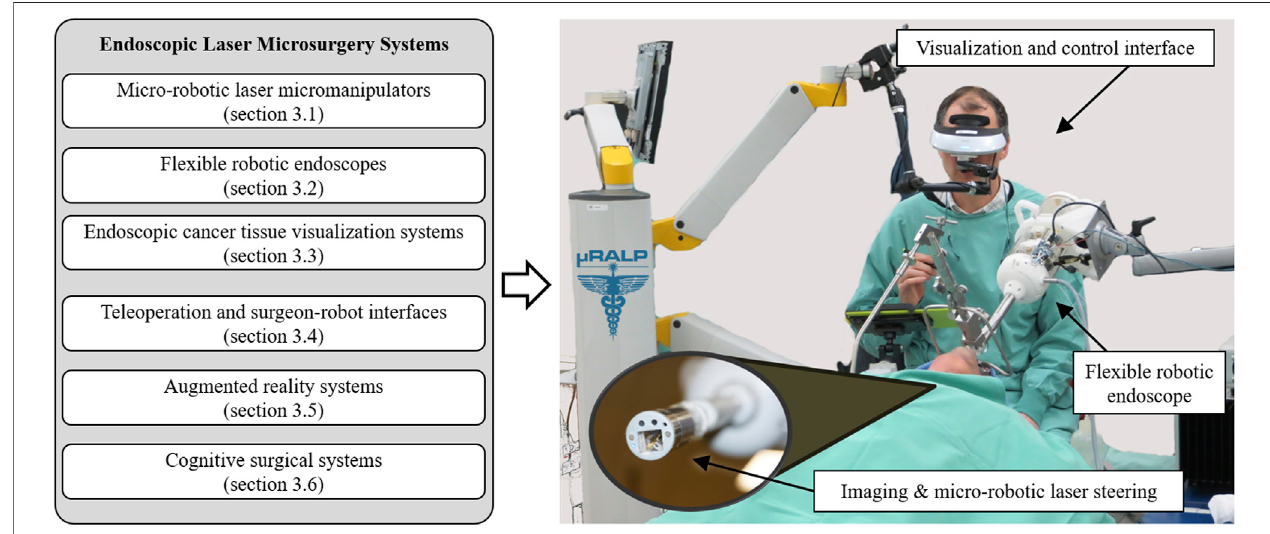
FIGURE2| Coretechnologiesofendoscopiclasermicrosurgerysystemsreviewedinthispaper.Thesetechnologiescanbeintegratedtocreateadvancedrobotic systems for delicate and high precision operations, such as demonstrated by the µRALP system for robot-assisted laser phonomicrosurgery shown on the right (Tavernier et al.,